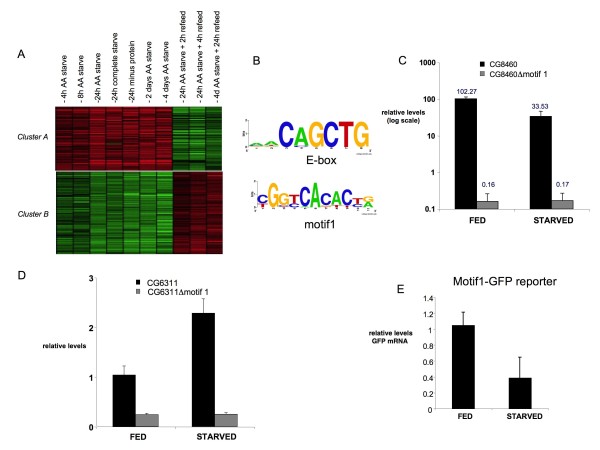
Motif 1 is a mediator of nutrition-dependent transcription. A. Heat-maps showing expression profiles of Cluster A and Cluster B genes. Columns indicate expression changes at different AA starvation/re-feeding time-points B. Weblogos of two motifs enriched in the promoters of AA starvation-regulated genes. C, D. Real-time qPCR data from transgenic larvae carrying promoter-GFP reporters for two different starvation-regulated genes. Black bars, wild-type promoter, Grey bars, motif1-mutated promoters. E. Real-time qPCR data from transgenic larvae carrying 5× motif1-GFP reporter.